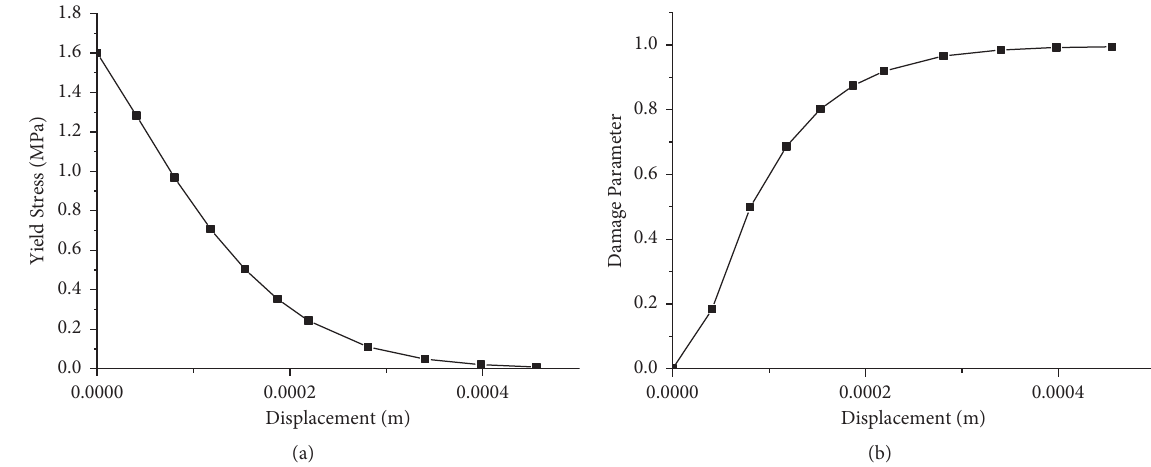
Figure 5: Dynamic tensile damage evolution curve of C